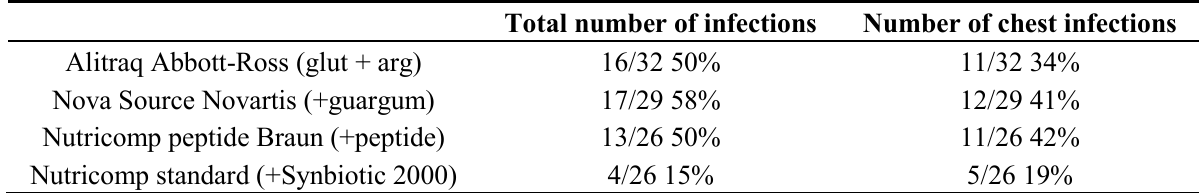
Table 9. Total number of infections and number of chest infections in severe trauma receiving four different commercial nutrition solutions of which one is combined with added Synbiotic 2000 [102].